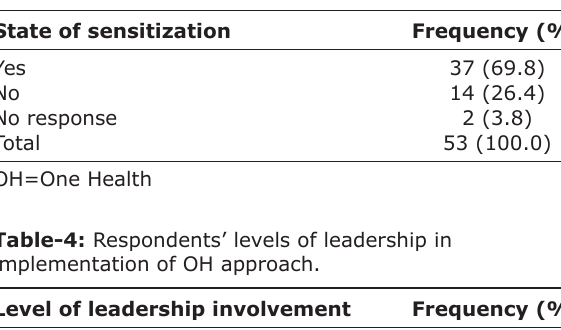
Table-1: Demographic and professional characteristics of the study participants.